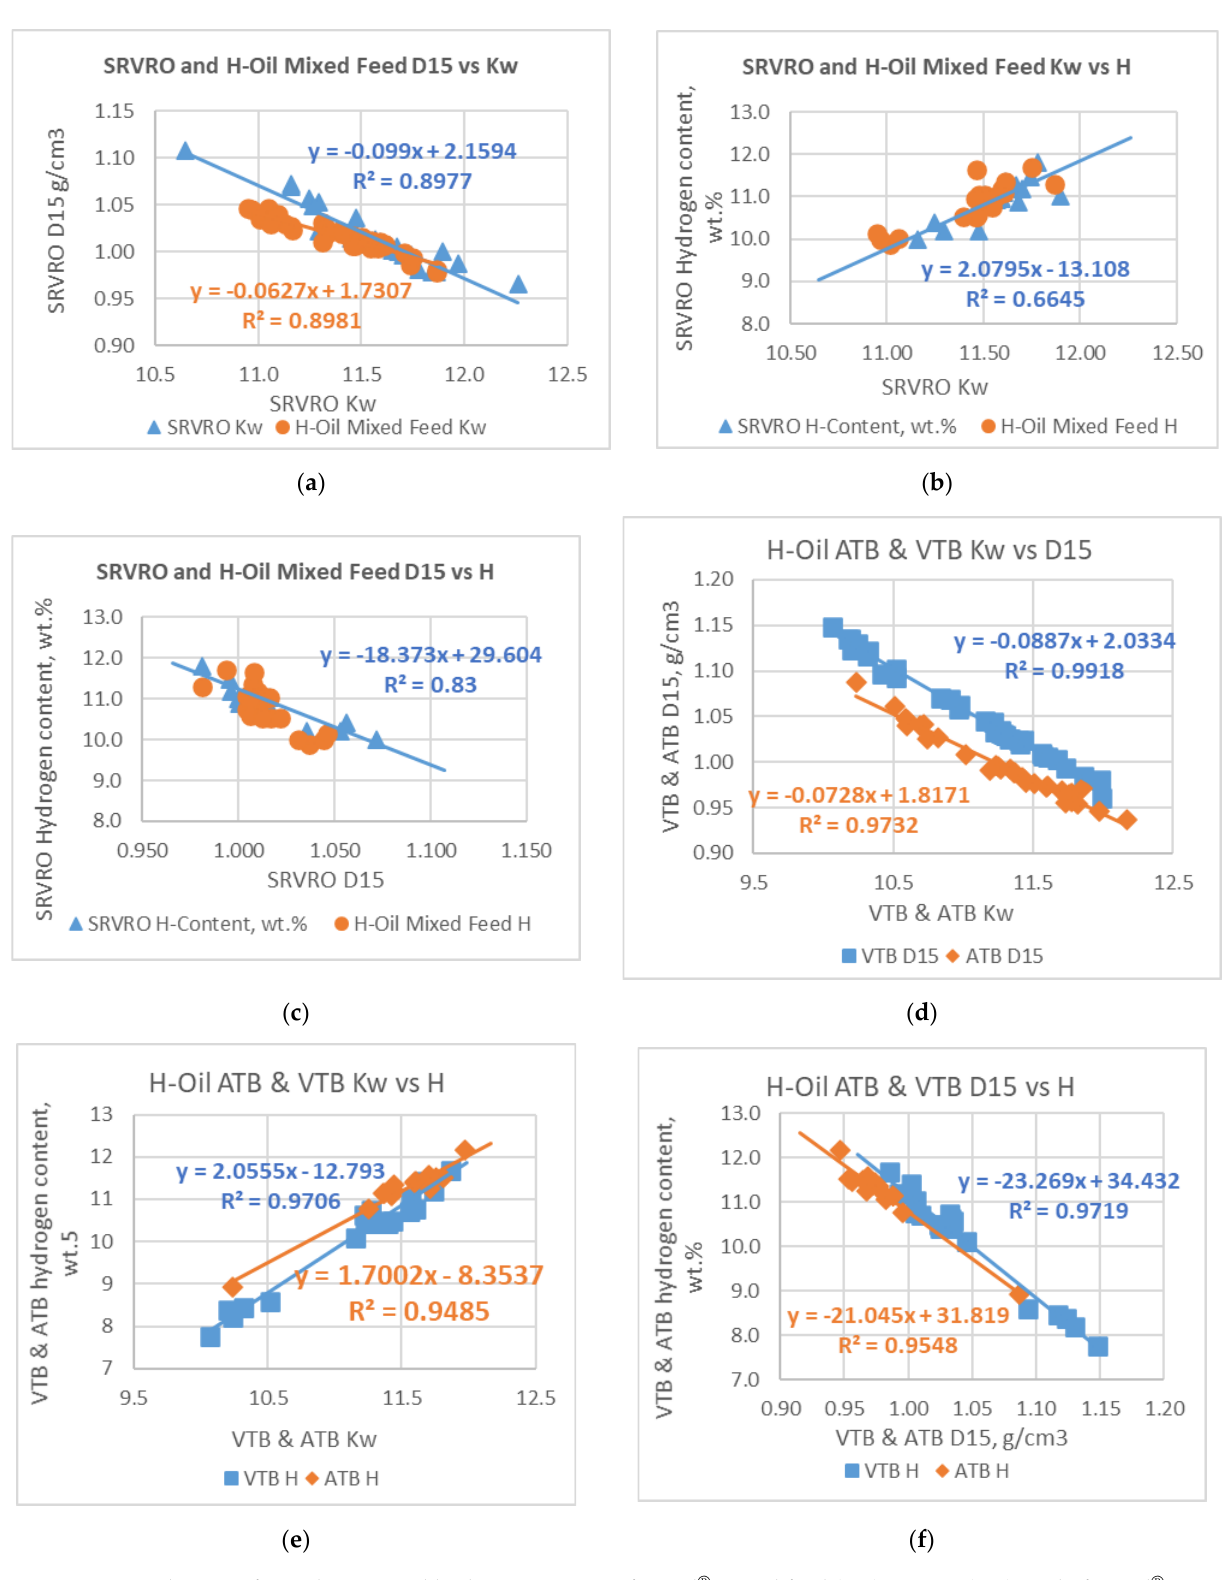
Figure 1. Correlations of Kw, density, and hydrogen content of H-Oil ® mixed feed ( a – c ) SRVRO ( a – c ), and of H-Oil ® ATB, and VTB ( d – f ).